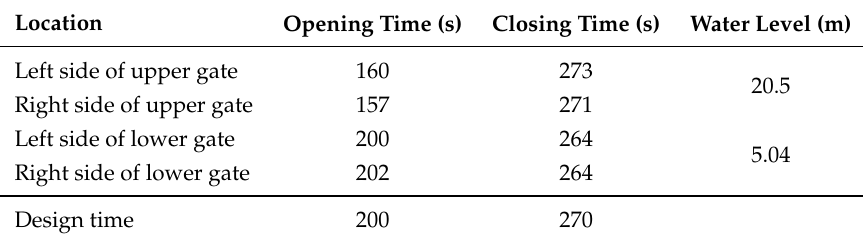
Table 2. Time statistics of the hydrostatic